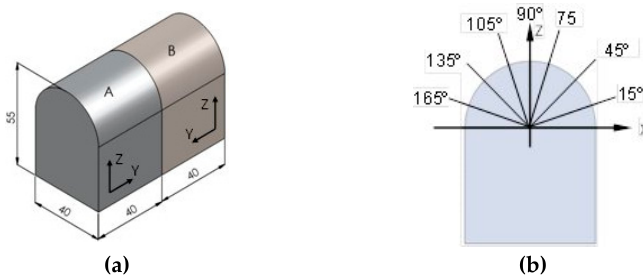
(b) Figure 4. ( a ) Example of roughness profile; ( b ) Taylor-Hobson Form Taylsurf Series 2 profile roughness tester. Figure 4a shows an example of a roughness profile. A quite regular profile with higher peaks than valleys was observed, which corresponds to ball-end milling. Although a high number of roughness parameters were measured, as shown in Figure 4a, parameters Ra and Rt were selected in order to obtain results related to a high averaging parameter ( Ra ) and a low averaging parameter ( Rt ). In addition, both roughness parameters are commonly used in roughness characterization [13,24]. 2.3. Photographs